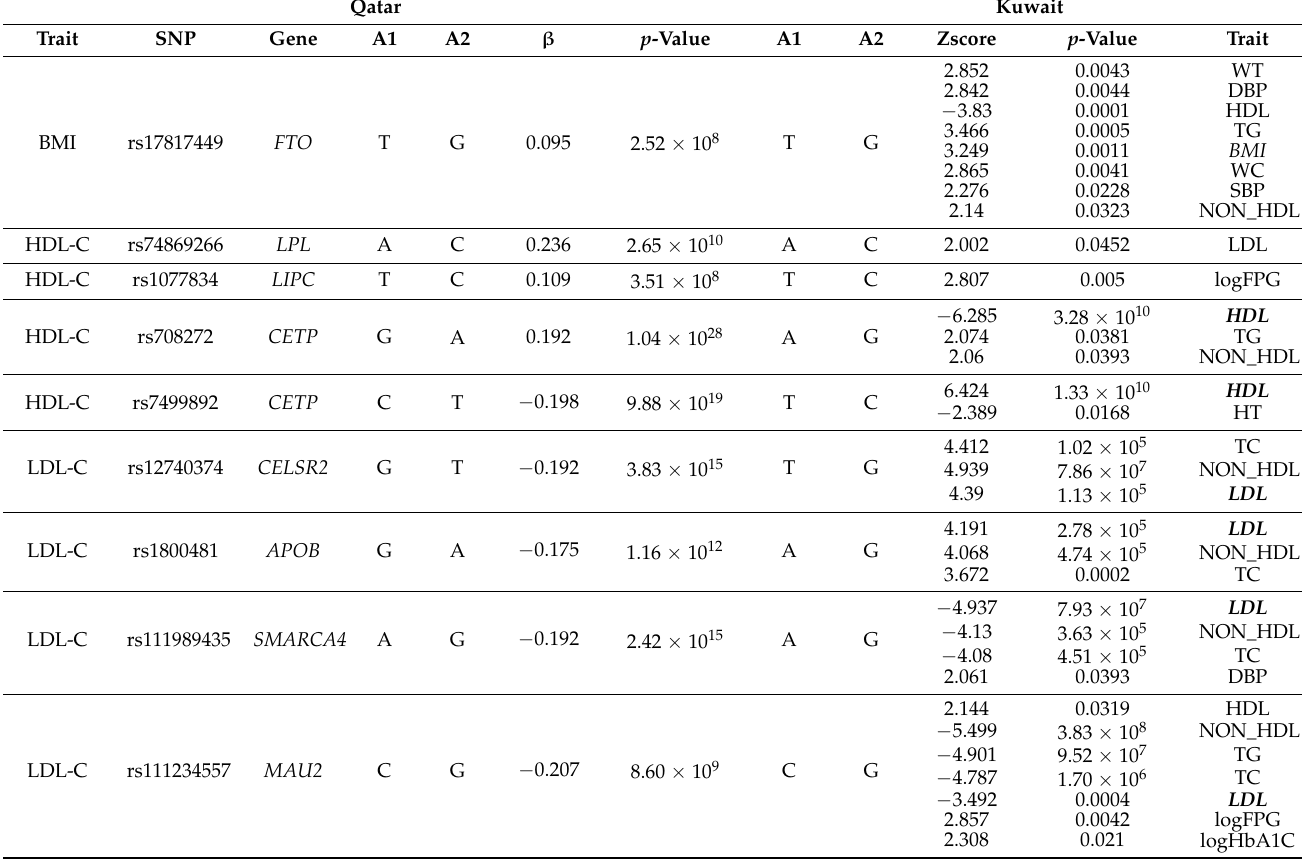
Table 1. GWA-identified association signals for lipid traits occurring in both the Kuwaiti and Qatari Cohorts. Qatar Kuwait